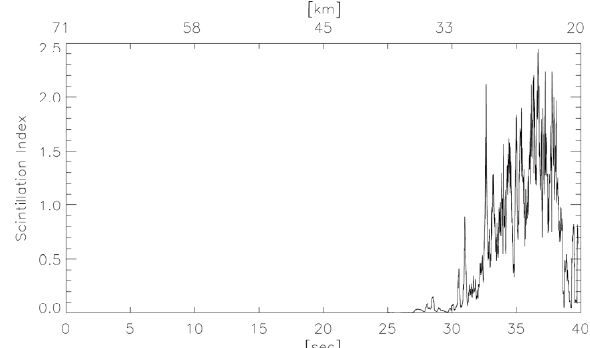
Figure 4 Scintillation index computed from the optical power recorded at OPALE for 0.1 second intervals, 07:22:00 UTC was set to 0 in this plot. Fig. 4. Scintillation index computed from the optical power recorded at OPALE for 0.1s intervals, 07:22:00UTC was set to 0 in this Figure 5 Angular fluctuation of the fine pointing mechanism along the x-direction recorded at OPALE, 07:22:00 UTC was set to 0 in this plot. The red line is the average calculated at 0.1 second intervals of the corrections.